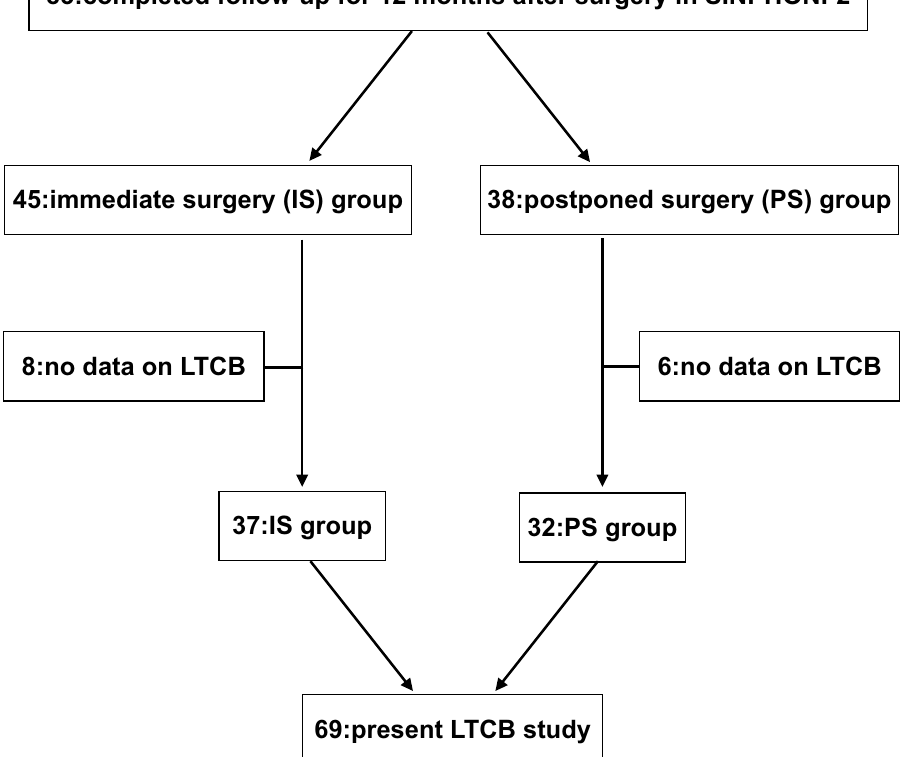
Figure 1. Flowchart of patient’s selection on present LTCB study. SINPONI-2 study of idiopathic normal pressure hydrocephalus on neurological improvement-2, LTCB long-term care